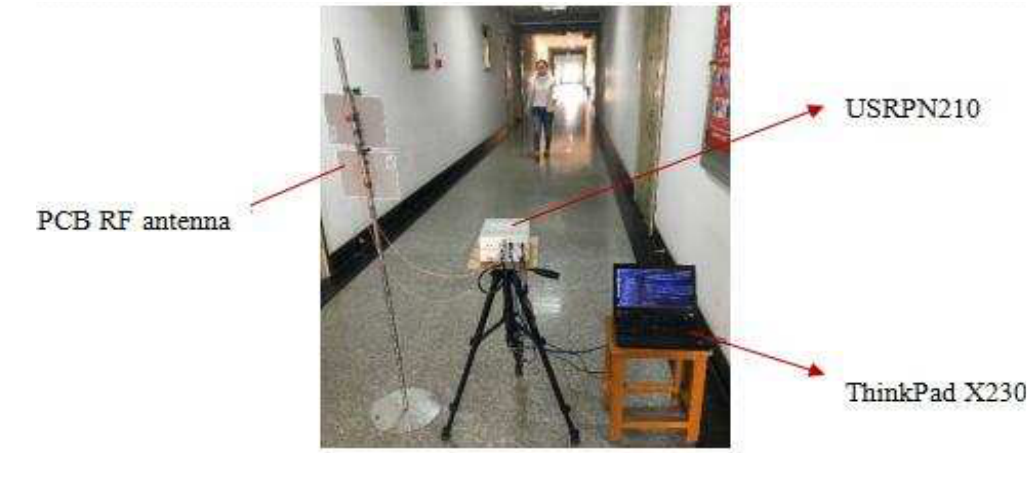
Figure 8. Experimental environment.